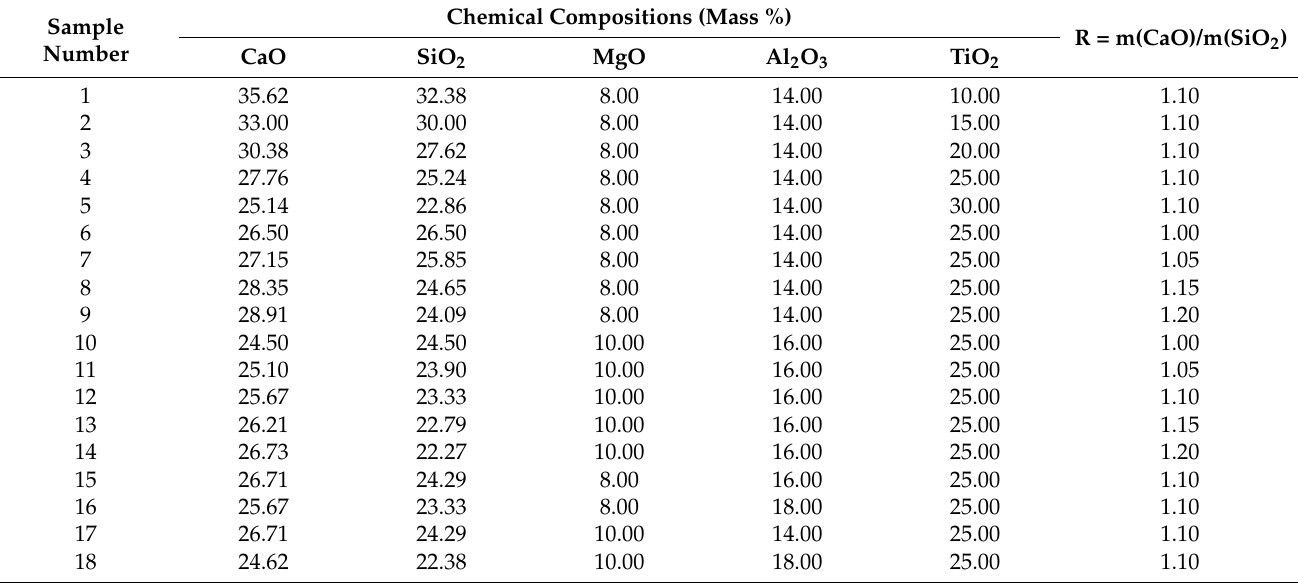
Table 1. The chemical composition of